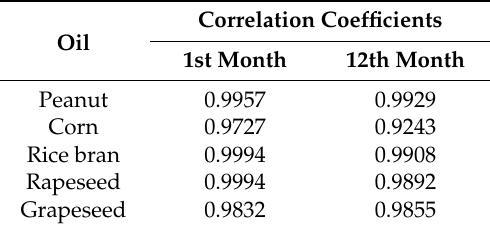
Table 3. Values of correlation coefficients between the Rancimat and Schaal Oven Test for selected oils.